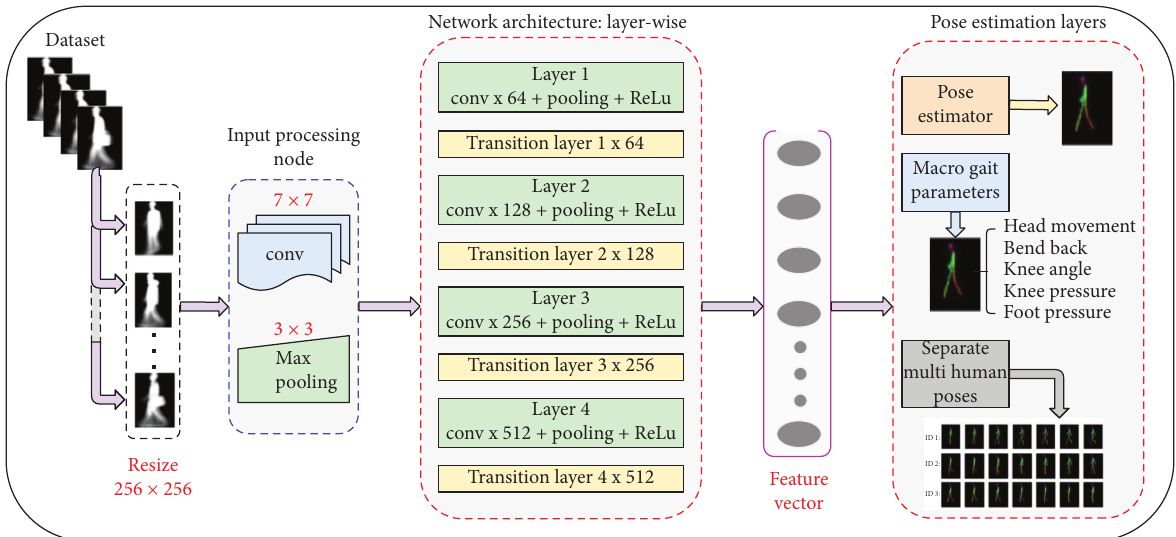
Figure 2: The framework of the proposed network using the CASIA-B dataset as training images and a few custom-collected datasets for training.